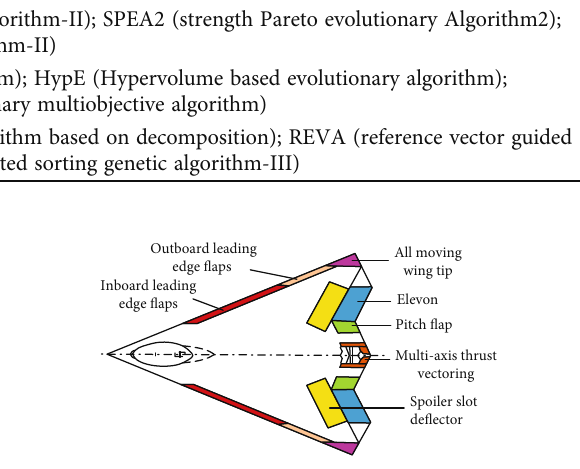
Figure 1: ICE aircraft control surfaces con fi